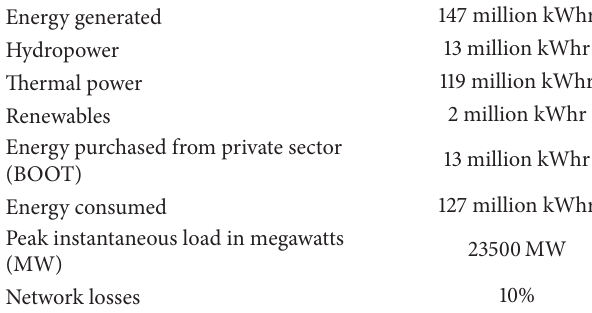
Table 3: Egypt’s electric data